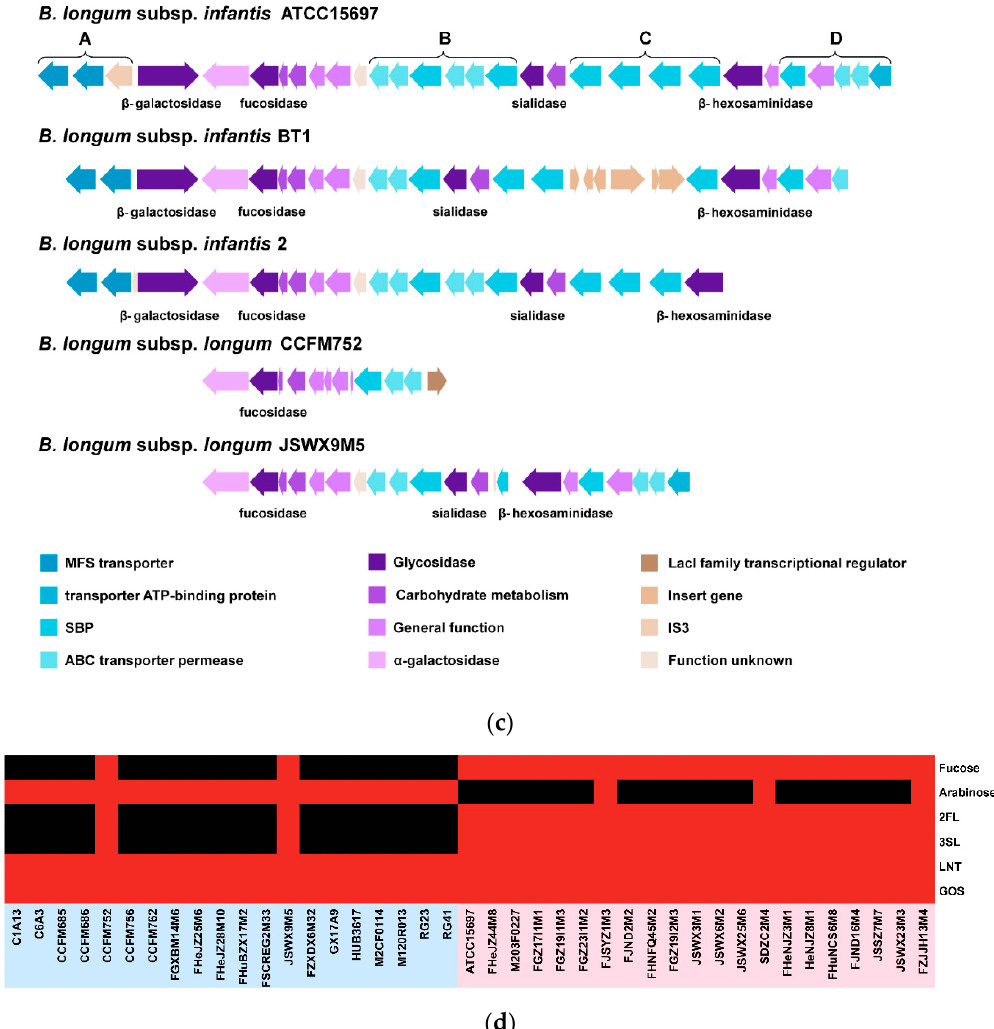
Figure 5. Carbohydrate utilisation genotype and phenotype of B. longum subsp. longum and B. longum subsp. infantis : The distribution and number of GH family genes ( a ) and GT family genes ( b ). The number of genes is represented by colour ranging from blue (absent) to red. ( c ) Predicted HMOs utilisation gene cluster in B. longum . ( d ) Carbohydrate metabolism capacity of B. longum . The horizontal axis represents the strains tested in this study and the vertical axis represents the six carbohydrates used in this test. Red for positive and black for negative. The blue area represents B. longum subsp. longum and the red area represents B. longum subsp. infantis .